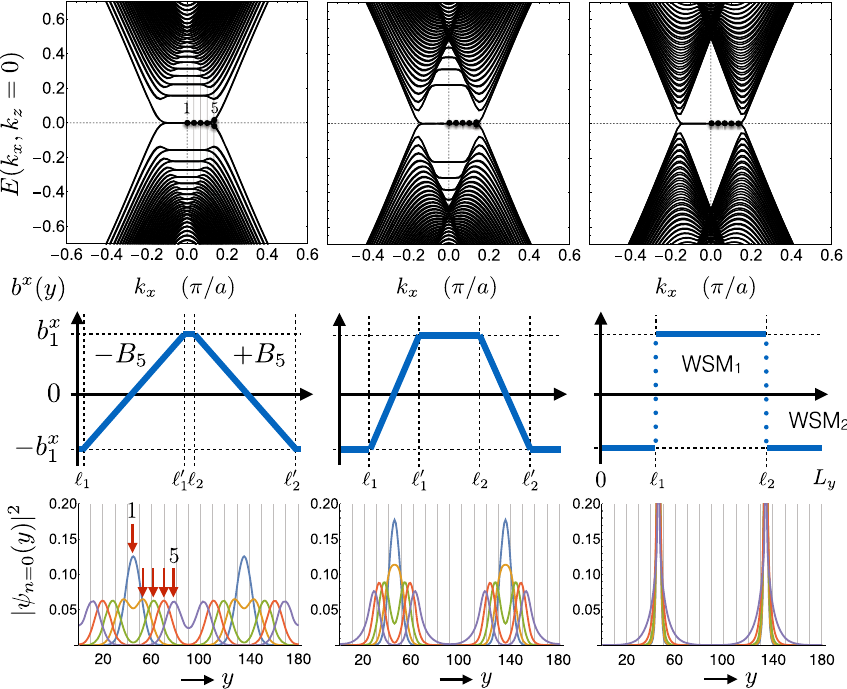
FIG. 2. Energy spectra (top row) obtained from Eq. (28) in the presence of a spatially varying b x ¼ b x ð y Þ , shown in the corresponding central panels. The spectra were calculated using m ¼ 0 . 0 and b x 1 ¼ 0 . 5 , such that the rightmost panels describe an interface between two Weyl semimetals (WSM 1 and WSM 2 ) with an inverted b axial vector. As a result, at each of the two boundaries, l 1 and l 2 , there will be two Fermi arcs, and the degeneracy of the zero-energy states connecting the bulk nodes is doubled compared to Fig. 1. The energy-level structure of the leftmost panel can be understood from the perspective of bulk axial magnetic fields. In each of the two regions, B z 5 ¼ þ B 5 and B z 5 ¼ − B 5 , two n ¼ 0 pseudo-Landau levels are present, one for each Weyl node, giving a total of four n ¼ 0 pseudo-Landau levels. The bottom panels show the support of the wave function of some E ¼ 0 states labeled by solid black circles as a function of y . The wave-function support demonstrates that the Fermi arc states (on the right) are the Landau orbitals of the n ¼ 0 pseudo-Landau level (on the left). We used l 1 0 − l 1 ¼ l 2 0 − l 2 ¼ ð 80 ; 40 Þ for the first two columns, ð l 1 ; l 2 Þ ¼ ð 45 ; 135 Þ for the 120 × 180 × 120 rightmost column, and a system size of L × L × L x y z ¼